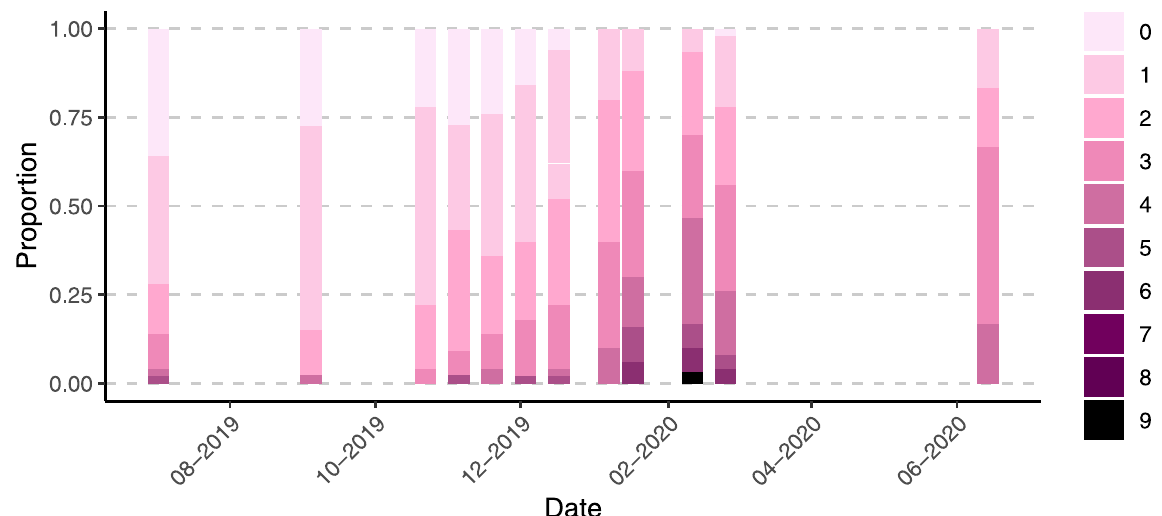
Fig 13. Distribution of welfare scores over time. Proportion of salmon with summed welfare scores between 0 and 9. A score of zero indicates that the fish had no injury at all and higher scores are more injuries.